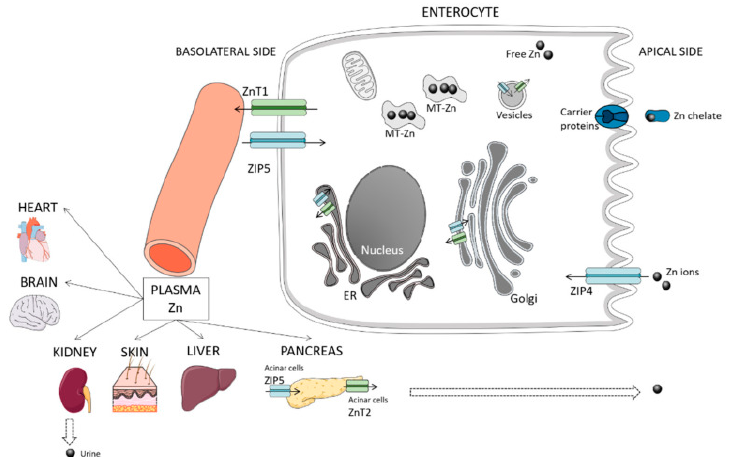
Figure 1. Simplified scheme of zinc metabolism: absorption and excretion from the intestine: ZIPS, ZIP4, ZnT1, and ZnT2—transporters of enterocyte membranes and intracellular components (shown in blue and green, respectively); excretion routes are shown by dotted arrows; ER—endoplasmic reticulum; MT—metallothionein; some organs (heart, brain, kidney, skin, liver, pancreas) that exchange zinc with the plasma pool are presented (adapted from [63]).